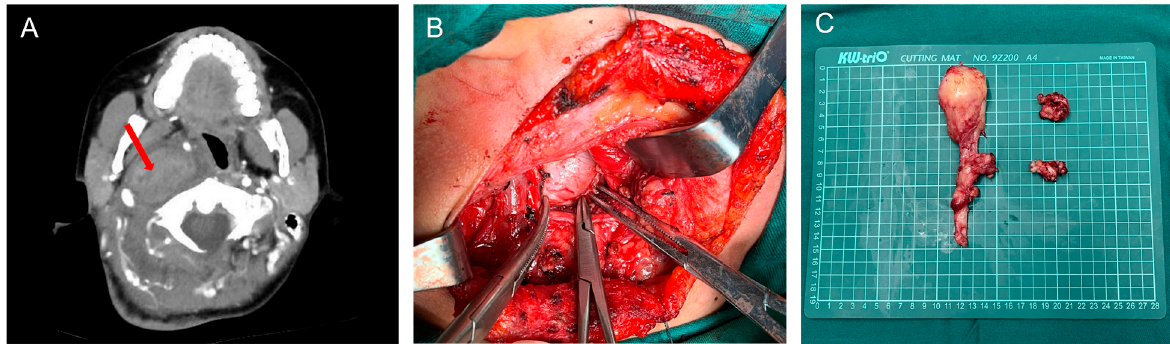
Figure 2. Distribution of the symptoms and signs of PPS lesions. ( A ) symptoms; ( B ) signs.